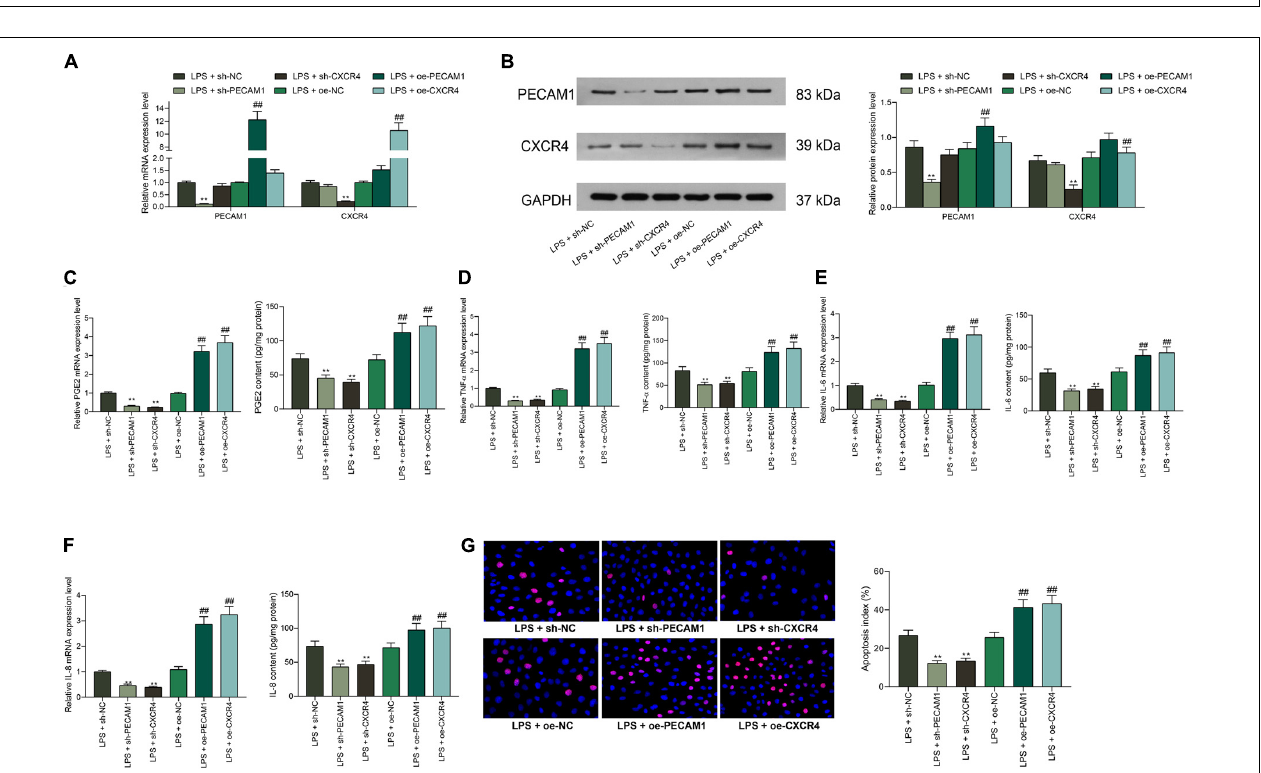
FIGURE 4 | Downregulation of PECAM1 and CXCR4 suppresses LPS-induced inflammation in HDPFs. (A,B) mRNA (A) and protein (B) expression of PECAM1 and CXCR4 in cells examined by RT-qPCR and western blot assays, respectively. (C–F) Levels of PGE2, TNF- α , IL-6, and IL-8 detected by ELISA kits. (G) Apoptosis of HDPFs determined by the TUNEL assay. Data were collected from three individual experiments and expressed as mean ± SD. Data were analyzed by one-way (C–G) or two-way ANOVA (A,B) followed by Tukey’s multiple comparison test. ** p < 0.01 vs LPS + sh-NC; ## p < 0.01 vs. LPS + oe-NC.